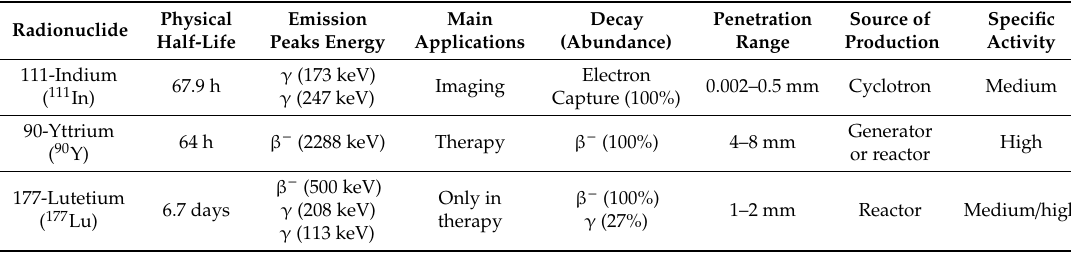
Table 1. Characteristics of PRRT Main